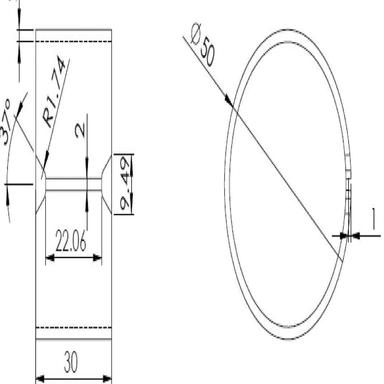
Engineering drawing of the GRHPST specimen.